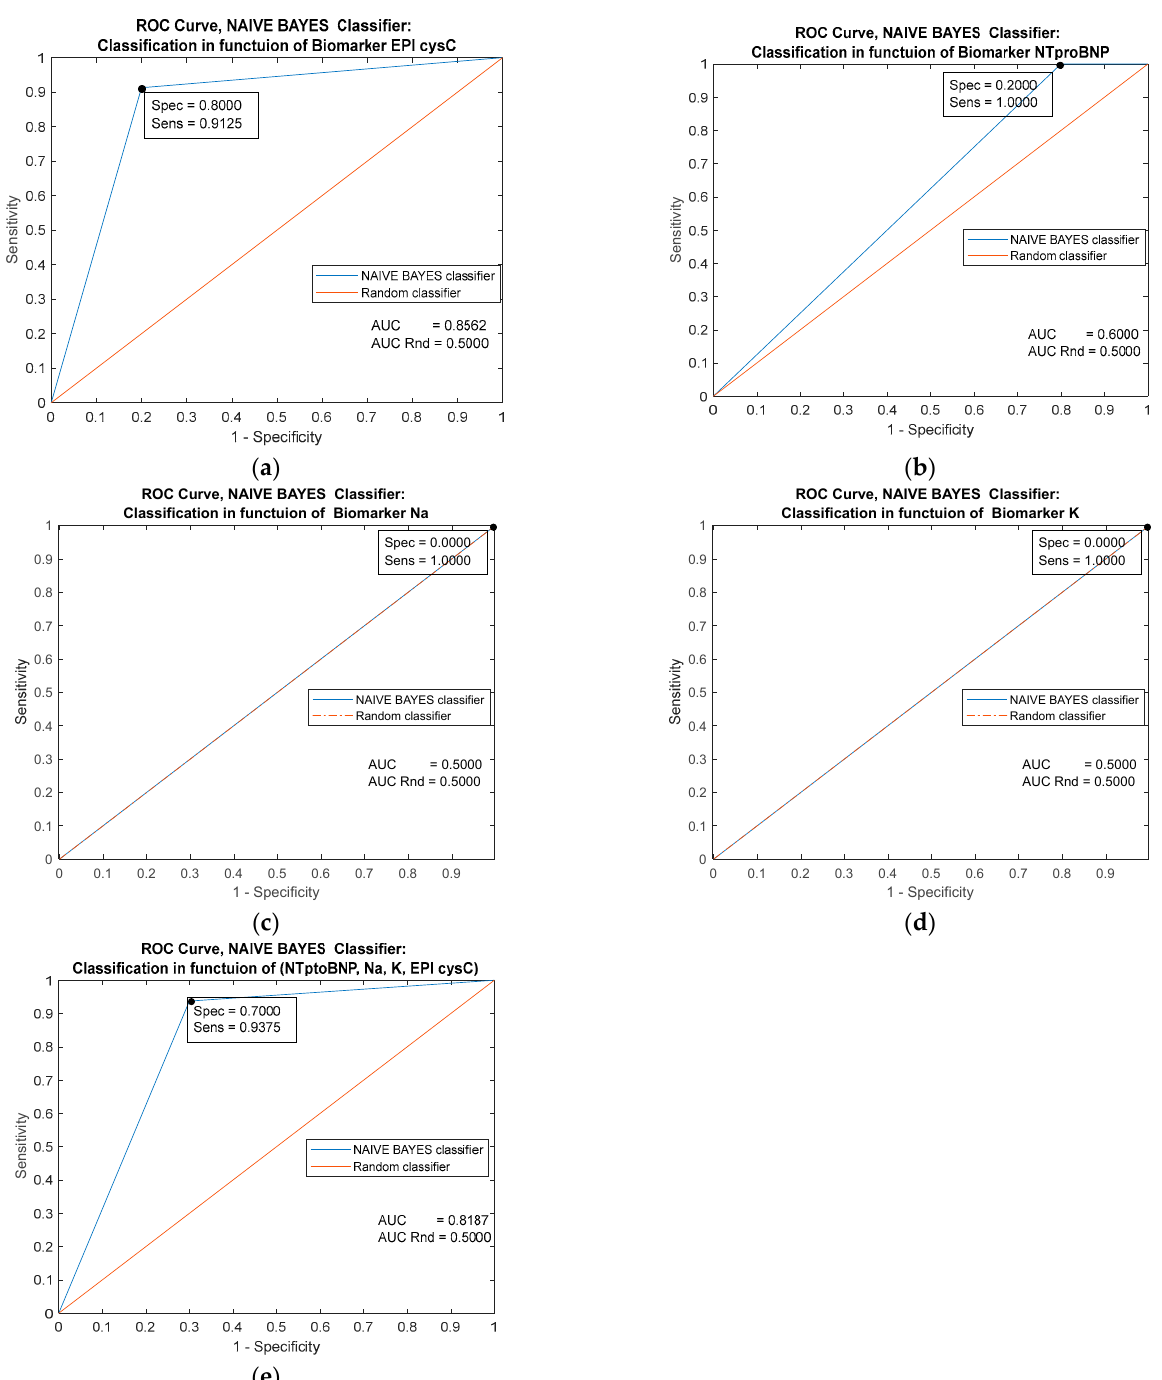
Figure 6. Performance comparison of the Naive Bayes Classifiers trained on four individual predictors ( a – d ) and on the combination of all mentioned predictors ( e ). The highest single prognostic significance has the biomarker NT proBNP Figure 7b (AUC = 0.9413). The classifier based on the combination of all predictors has good per- formance Figure 7e (AUC = 0.9863 and specificity = 0.9000). The predictors Na and K Figure 7c,d have very weak prognostic significance in the case of this classifier and behave similarly to a random classifier (AUC <